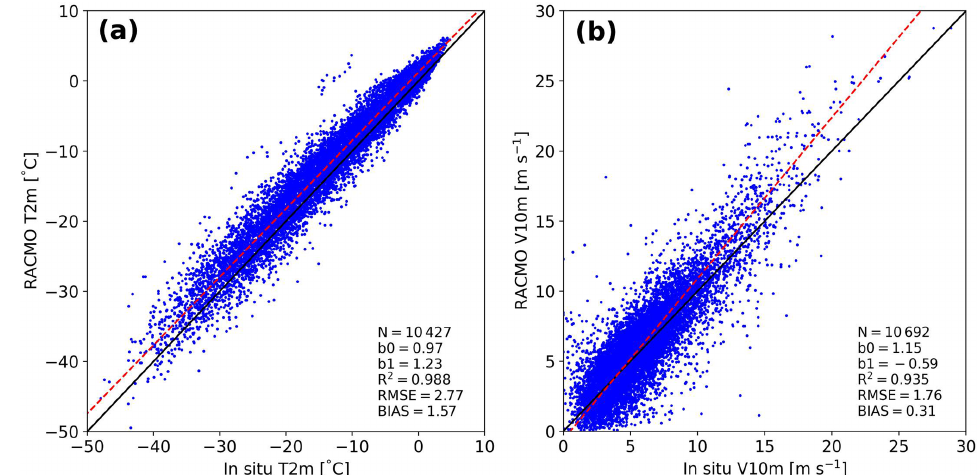
Figure B1. Daily-averaged (a) atmospheric 2m temperature ( T 2m ) and (b) 10m wind speed ( V 10m ) of Rp3 compared to in situ observations between 2006 and 2015 for S6 and S9 (S10 is not available) of the K-transect and KAN-U and KAN-M of PROMICE. The black line is the one-to-one line, and the red line shows the orthogonal total least-squares regression of the data, with b0 the slope and b1 the intercept. Number of records ( N ), determination coefficient ( R 2 ), root-mean-square error (RMSE, in ◦ C and ms − 1 , respectively), and bias are displayed.